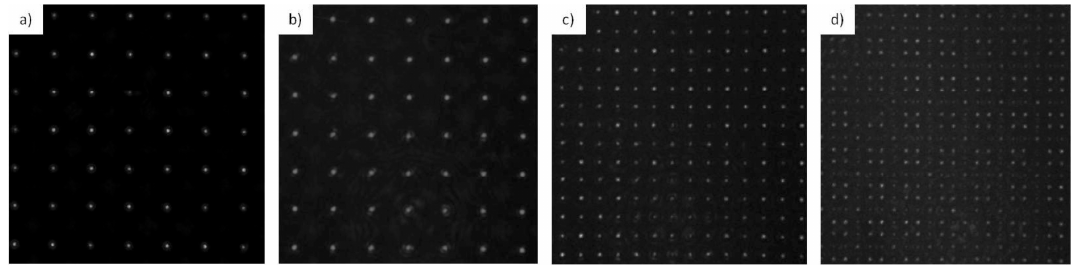
Figure 3. CCD-images recorded with the setup described in Figure 2 of the ( a ) foci of the microlenses; ( b ) first Talbot plane; ( c ) 3/2 Talbot plane; and ( d ) 5/3 Talbot plane. All images were taken at the same scale.